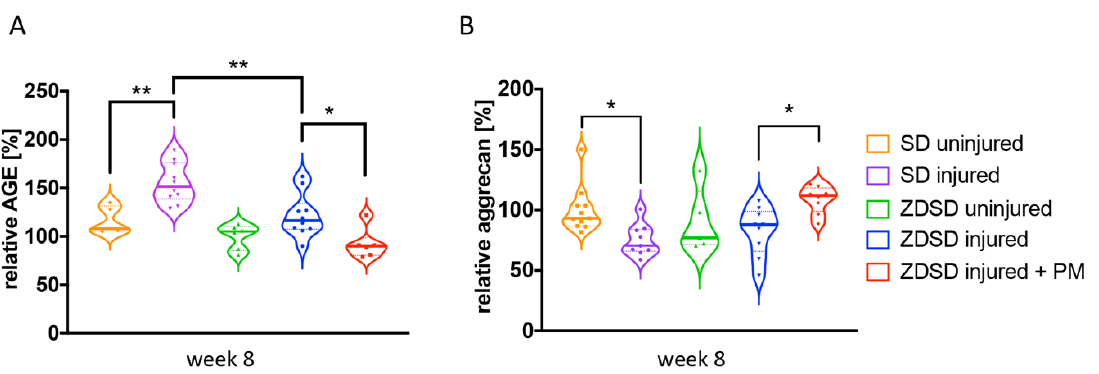
Figure 4. PM treatment decreases AGE levels and increases aggrecan levels in needle-injured IVDs. ( A ) Relative levels of AGE protein and ( B ) relative levels of aggrecan accumulation in homogenized IVD samples normalized to the levels detected in the ZDSD uninjured group. * p < 0.05, ** p < 0.01.